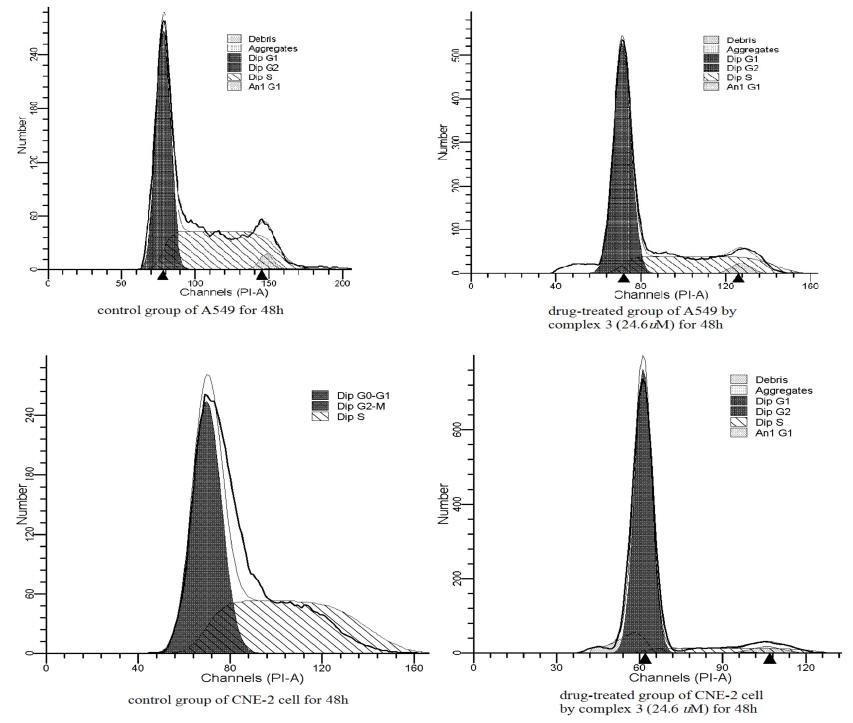
Figure 11. The cell cycles of A549 and CNE-2 treated with 24.6 µ mol/L complex 3 for 48 h by